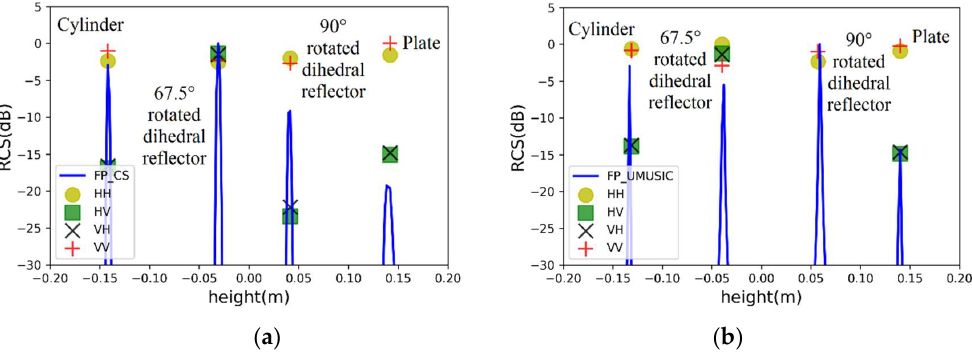
Figure 6. Estimated heights of four point scatterers with a spacing of 0.09 m by ( a ) fully-polarimetric DCS and ( b ) fully-polarimetric UMUSIC. Table 4. Estimated results of two point scatterers with a spacing of 0.09 m.